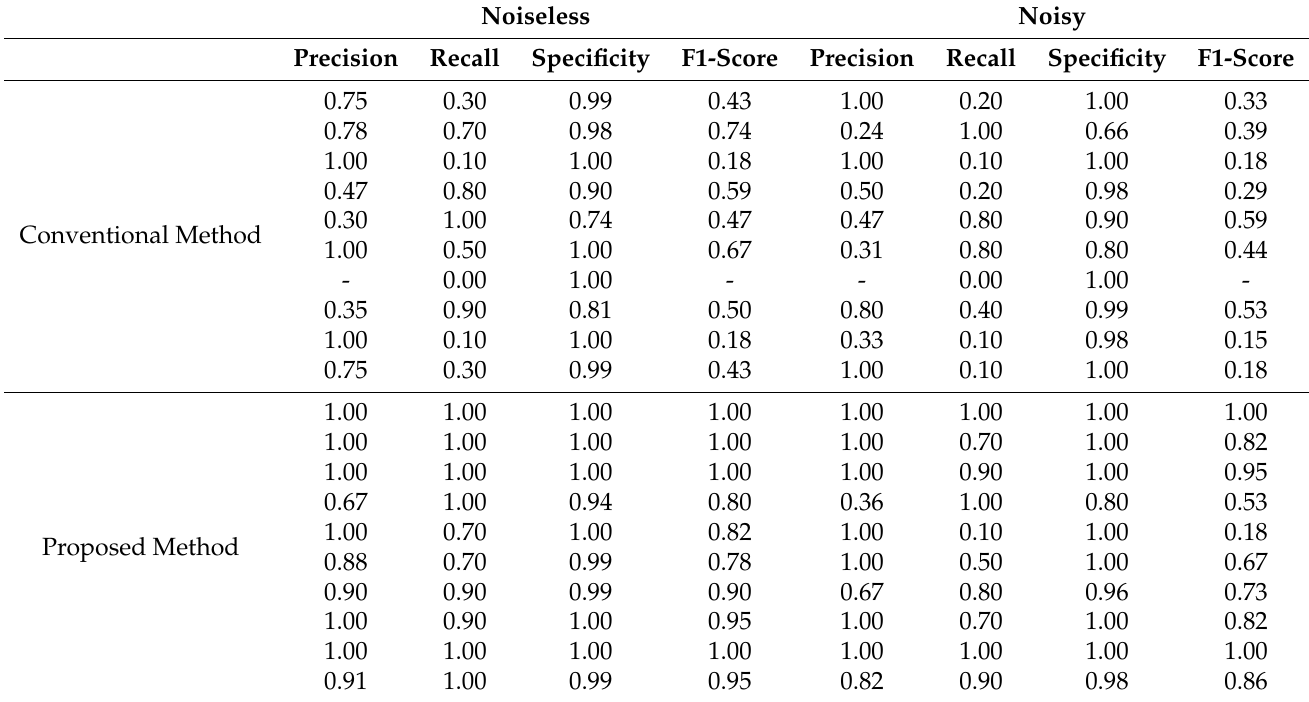
Table 7. Precision, recall, specificity, and F1-score of the conventional method and the proposed method. Noiseless Noisy Precision Recall Specificity F1-Score Precision Recall Specificity F1-Score